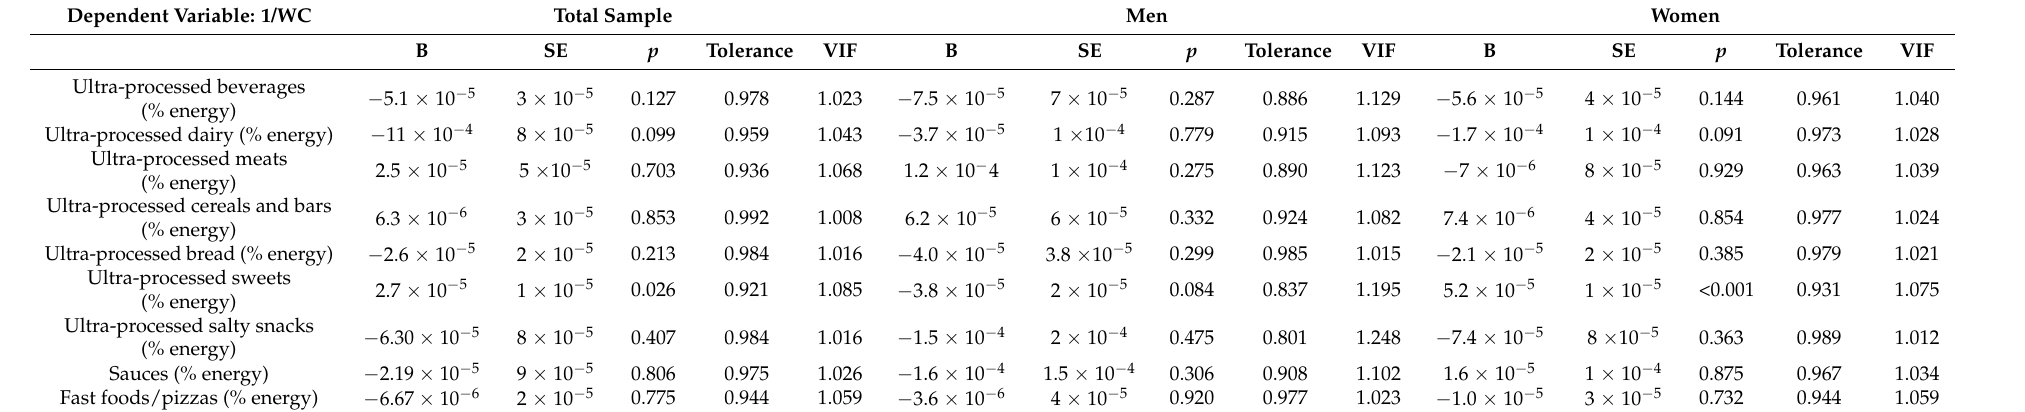
Table 4. Linear regression analysis for 1/WC in the total sample, men and women with processed food groups as independent variables (one group in each